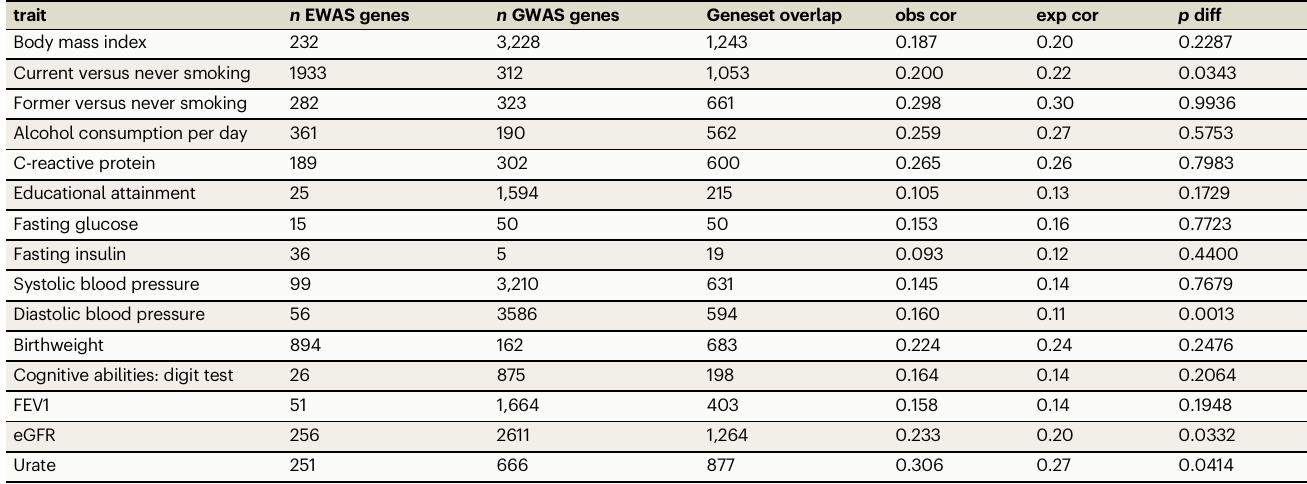
Table 3 | Correlation of geneset enrichment scores between EWAS and GWAS